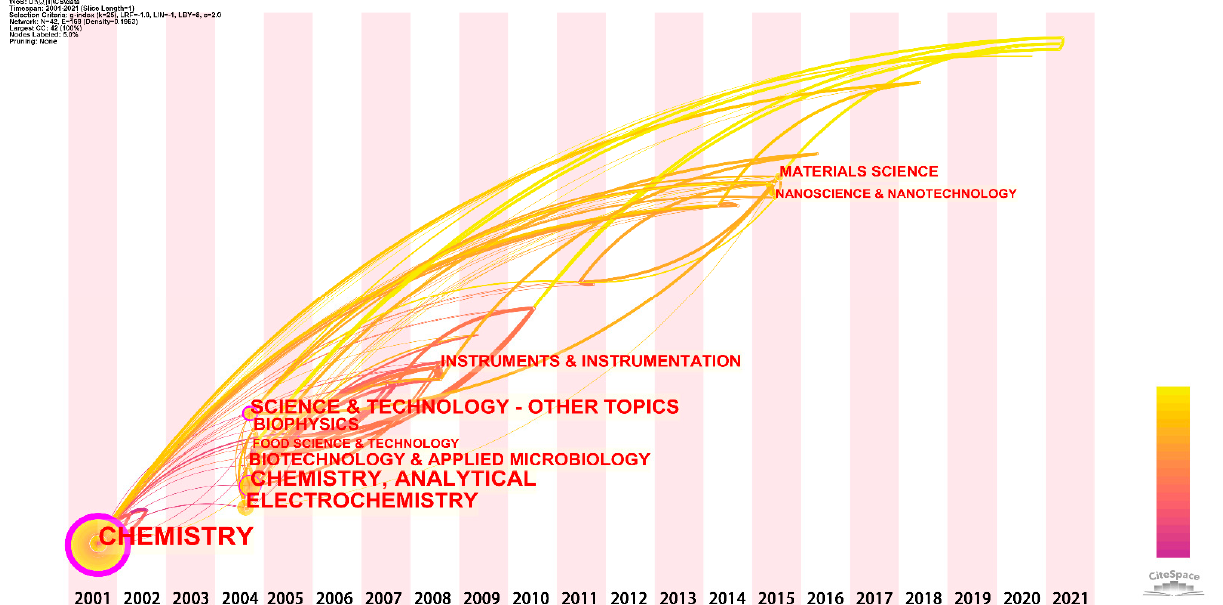
Figure 4. Time-zone view of research categories for electrochemical techniques for the detection and analysis of GM crops.